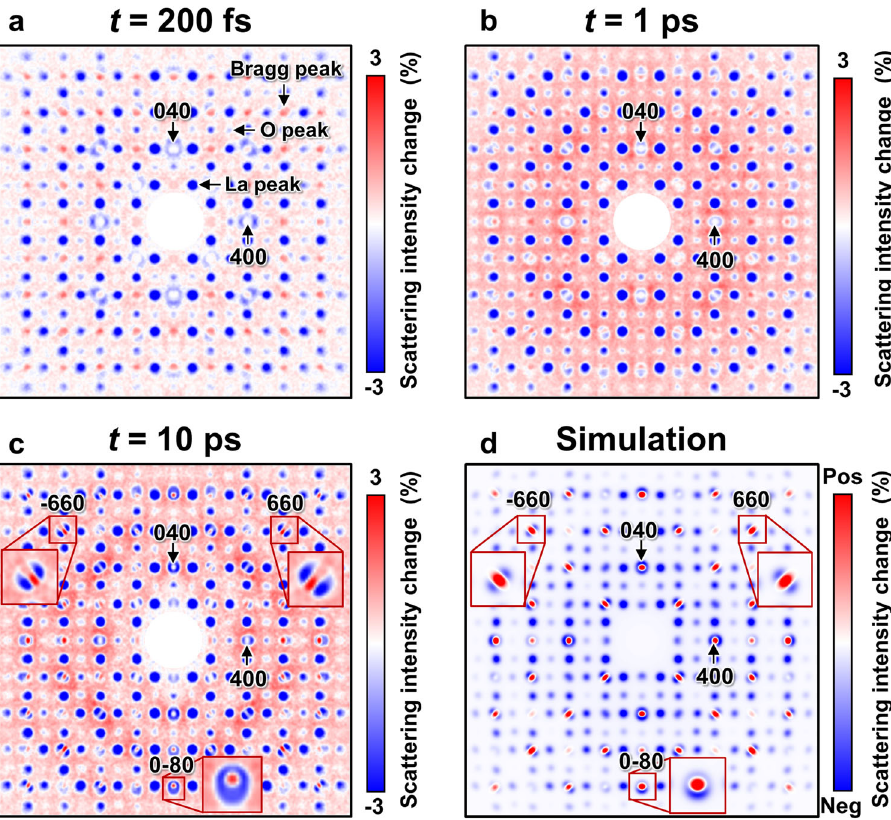
Fig. 2 Evolution of the diffraction intensity at three key time delays. a – c Experimental difference maps by subtracting the diffraction pattern before time zero from the diffraction pattern at t = 0.2 ps ( a ), t = 1 ps ( b ), and t = 10 ps ( c ). d Simulated UED difference map of t = 10 ps using the structure based on our observed lattice dynamics (see text). A few special re fl ections are magni fi ed in ( c ) and ( d ) to show their distinctive intensity distributions in the difference map and the good agreement between experiments and calculations. Blue and red represent intensity decrease and increase, respectively. The pump fl uence is 6 mJ cm − 2 for all UED measurements. In order to better display the results of Δ FWHM transition, the color scale range is chosen to be ±3% for which the intensity change higher than 3% is a − b + c − and a − b − c + primary twin variants or domains. Here the parent phase is the pseudocubic substrate during fi lm growth. For each primary twin variant, it can form four second twin variants by aligning their {110} plane with the {110} plane of the parent phase 38 . The UED pattern therefore is a superposition of 12 〈 001 〉 zone diffraction patterns, each corresponding to an individual twin variant. When the lattice parameter along ‘ + ’ axis and ‘ − ’ axis are different, e.g. a ≠ b in the a + b − c − and a − b + c − twin pair, the spots split because the ‘ + ’ axis of the twin variant a + b − c − rotated about 90° with respect to the a − b + c − , as shown in Supplementary Fig. 7g. Note, we de fi ne the in-phase rotation axis ( ‘ + ’ axis) as the a -axis for all twin variants in Supplementary Fig. 7 to describe the twining relationship that is commonly used in crystallography. Under such a notation, because all twin variants have the same lattice in which the ‘ + ’ axis is assigned to the a -axis, the [001] or [010] of the a + b − c − and a − b + c − , and the [100] of the a − b − c + domains are parallel to the fi lm normal. For simplicity in Figs. 1 and 2 we index the diffraction patterns based on a universal description of lattice of the twin variant a + b − c − 3 , as circled in Supplementary Fig. 7a. Because of the relatively large size of the electron beam, the spots we observed are signi fi cantly broadened and the spot split becomes elongation (Supplementary Fig. 7h). In the simulations, we reached excellent agreement between the simulated UED pattern (Fig. 1d) and the experiment (Fig. 1c) based on the 12 twin variants in the system, when using the lattice parameter of 7.876 Å for the ‘ − ’ axes and 7.772 Å for the ‘ + ’ axis with octahedral rotation angles of 7.5° and 6.0° for the ‘ − ’ rotation and ‘ + ’ rotation, respectively. In the simulation, the Jahn – Teller